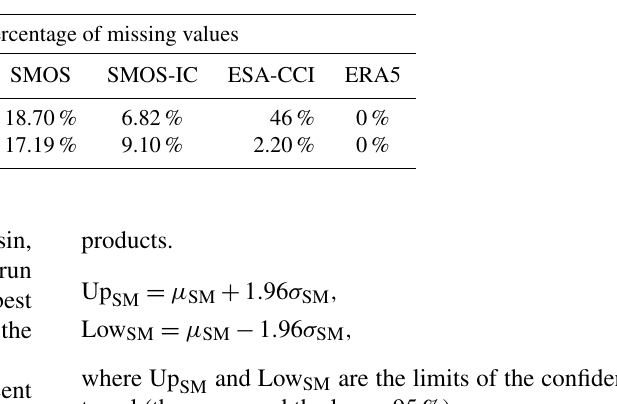
Table 4. Percentage of missing values for the different soil moisture products between 2013 and